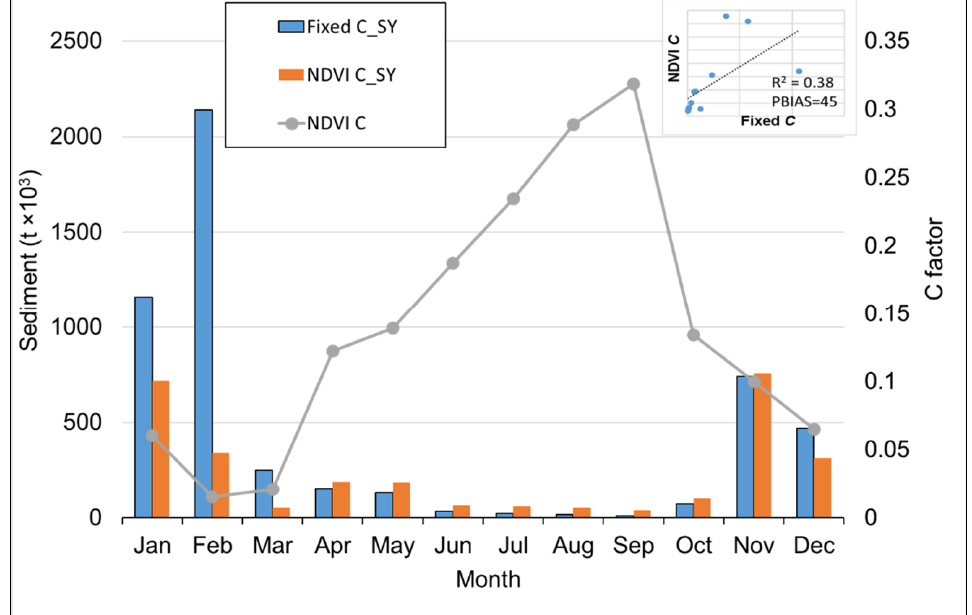
Figure 6. Distribution of sediment yield (SY) simulated using the fixed and variable (NDVI) C factors for catchment T35C in 2017.